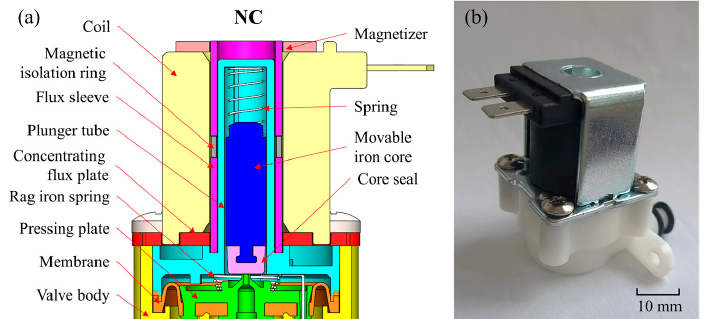
Figure 1. ( a ) Structural diagram and ( b ) optical image of the solenoid valve; the initial working air gap of the model is 12.16 mm, and the working stroke of the movable iron core is 5